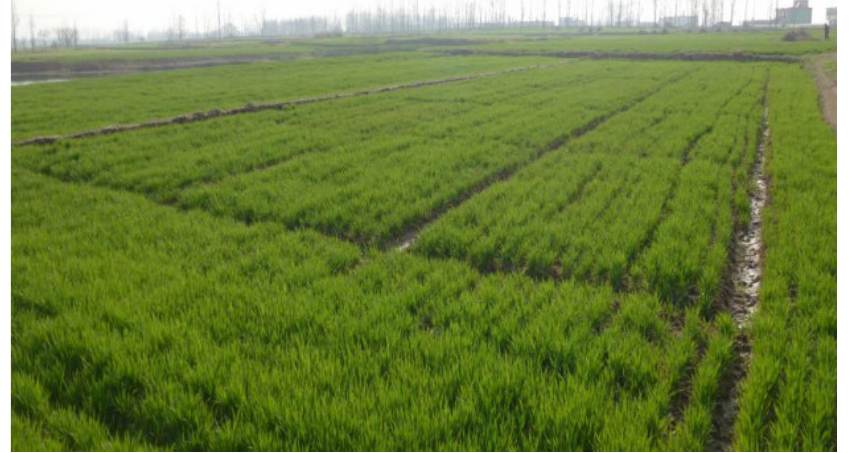
Figure 1. Farmland